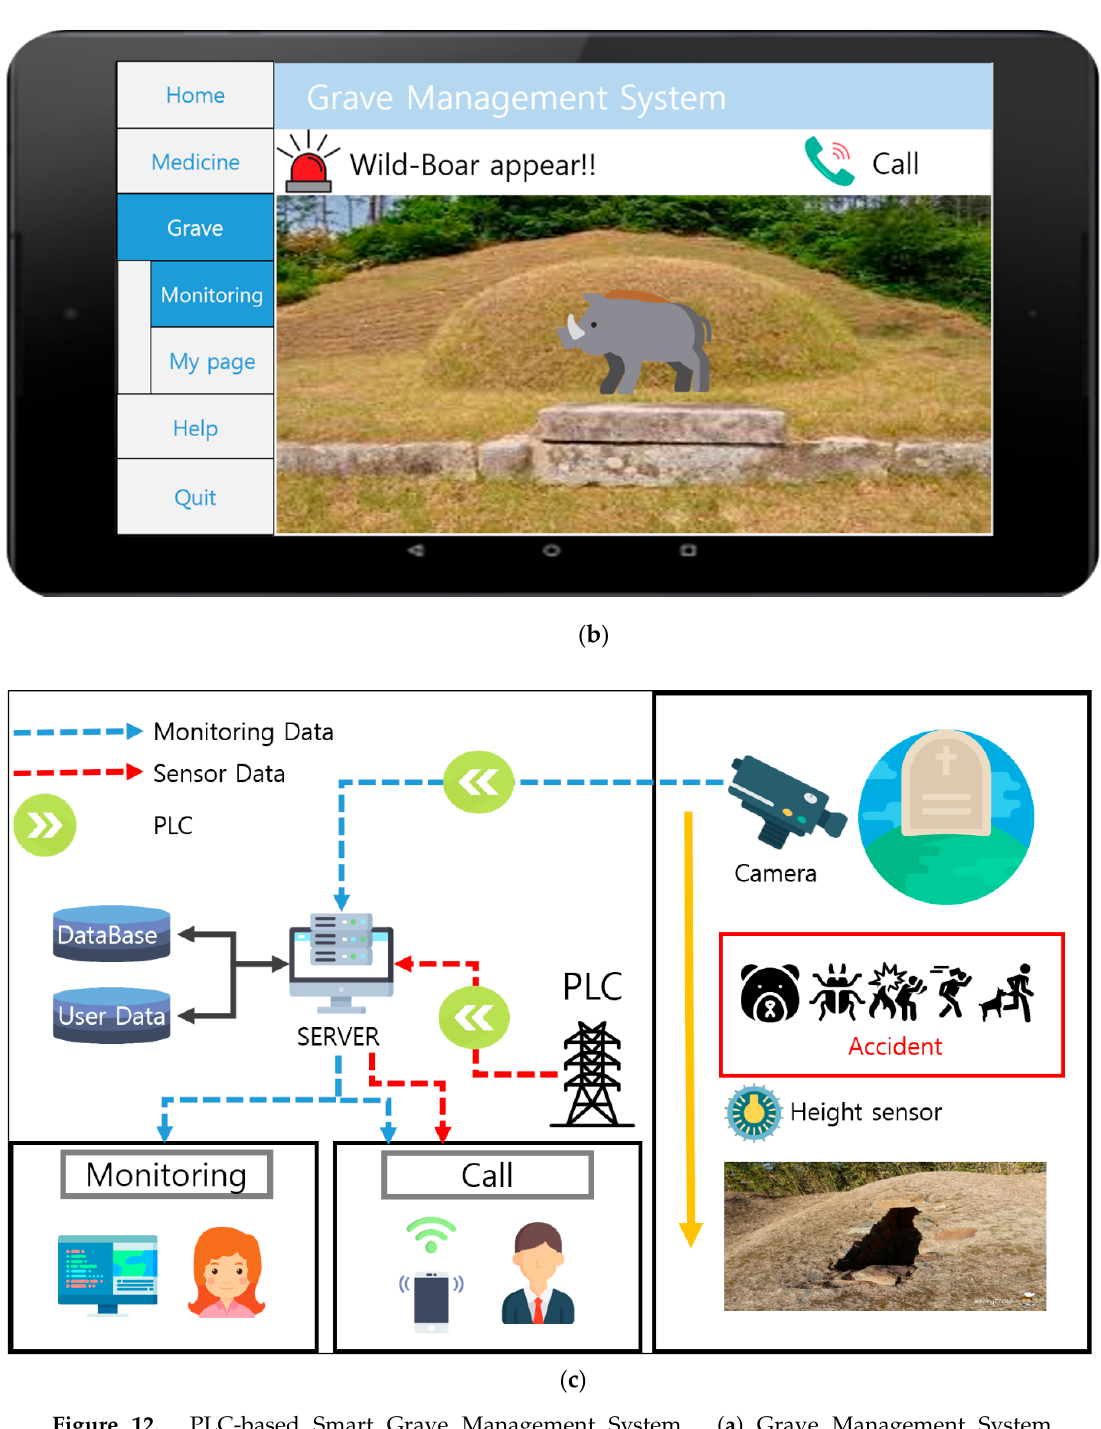
Figure 12. PLC-based Smart Grave Management System. ( a ) Grave Management System Application (1). ( b ) Grave Management System Application (2). ( c ) Smart Grave Management System.